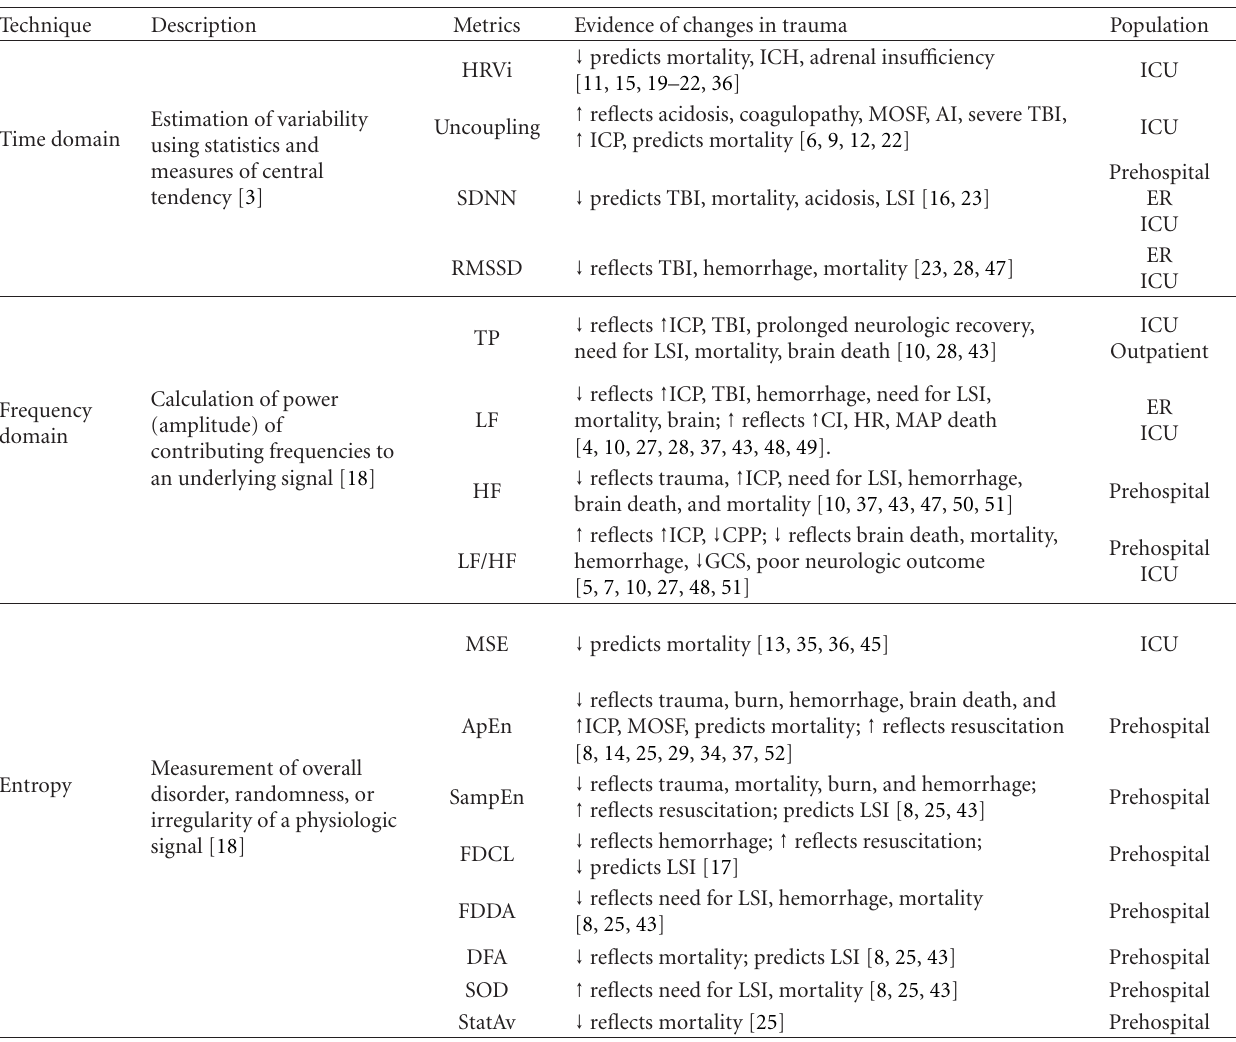
Table 4: Heart rate variability analysis techniques and their uses in